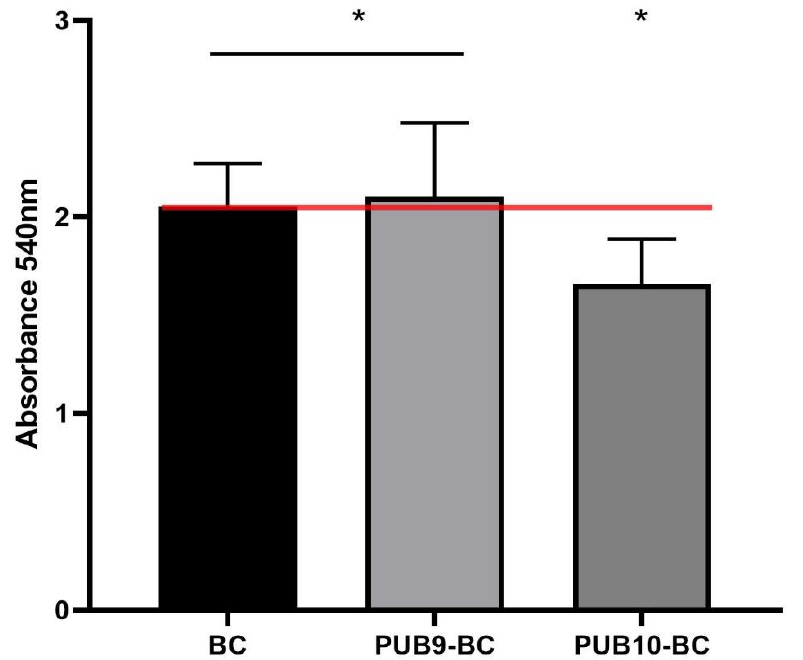
Figure 6. Comparison of cytocompatibility of isoxazole derivatives-fortified cellulosic carriers: PUB9- BC and PUB10-BC compared to control setting (cellulose carrier containing no isoxazole derivative) toward fibroblast cell line. Asterisks indicate significant differences ( p < 0.05, ANOVA Test with Tukey’s multiple comparison test) between BC vs. PUB10-BC and PUB9-BC vs. PUB10-BC . The red line indicates the maximal potential cellular growth (of non-fortified cellulosic carrier).